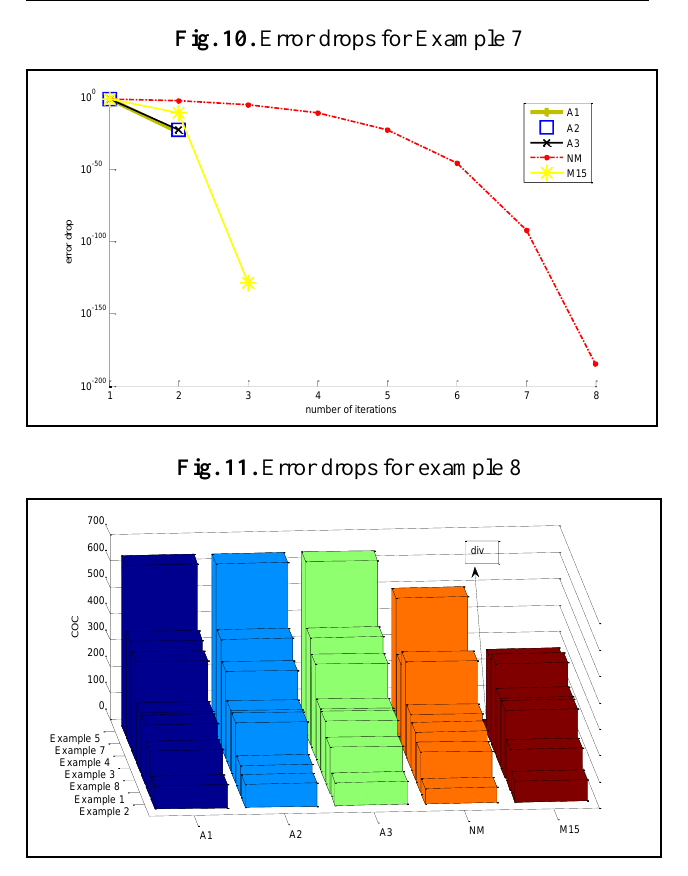
Fig. 12. COC in examples 1-5 and 7-8